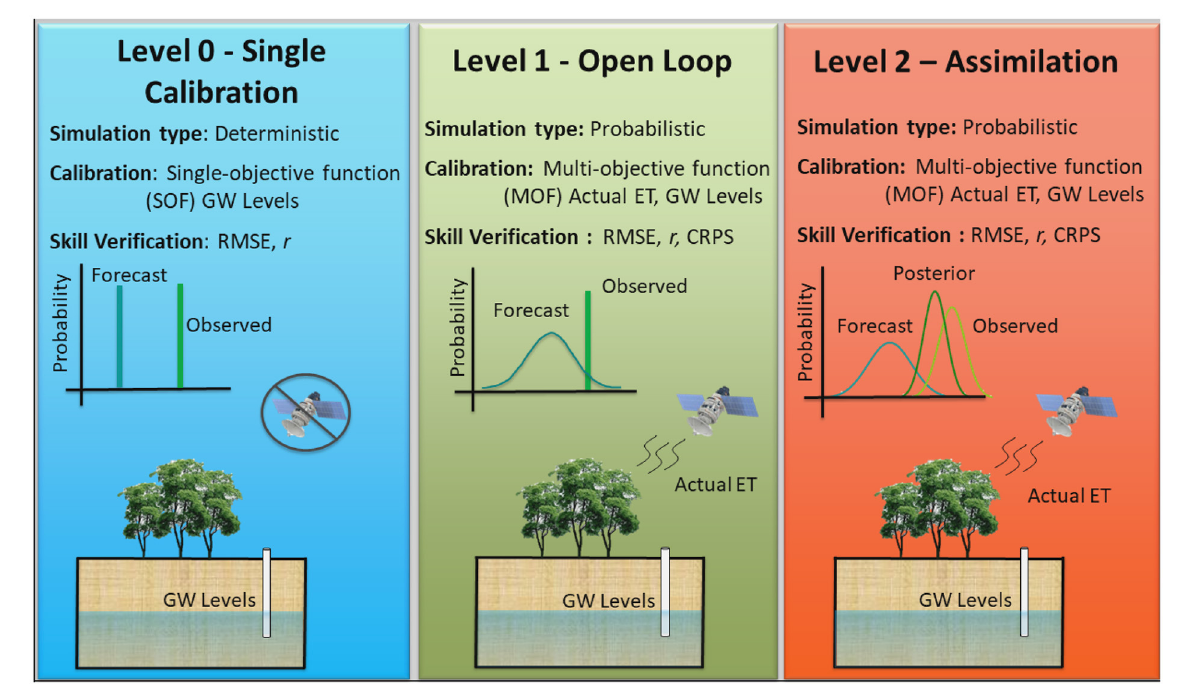
FIGURE3 Simulation levels. In the probability inset: Forecast means the modeled actual ET. Observed means the satellite-based actual ET, which can be a single value, as in the case of Level-1, or a distribution, as required by the EnKF. Posterior means the distribution resulting from the filter